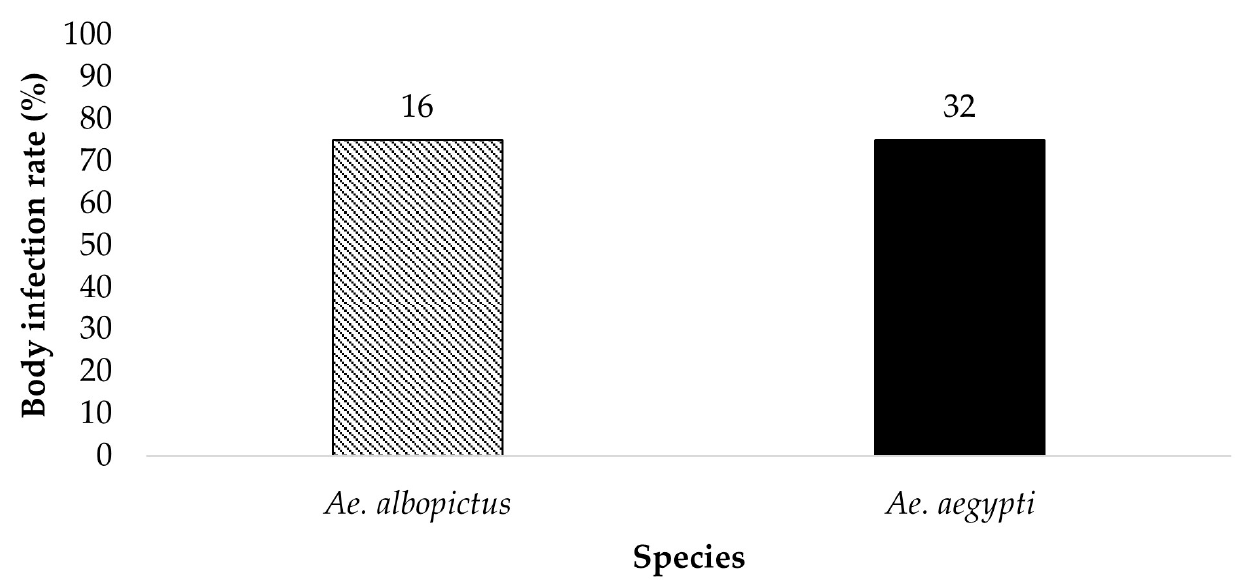
Figure 2. All bodies were tested for the presence of ZIKV infection. The results show the susceptibility to ZIKV infection of parental Ae. aegypti and Ae. albopictus from the treatment groups ingesting infected blood at a dose of 7 log 10 PFU/mL. The numbers above the bars represent the number of mosquitoes tested.